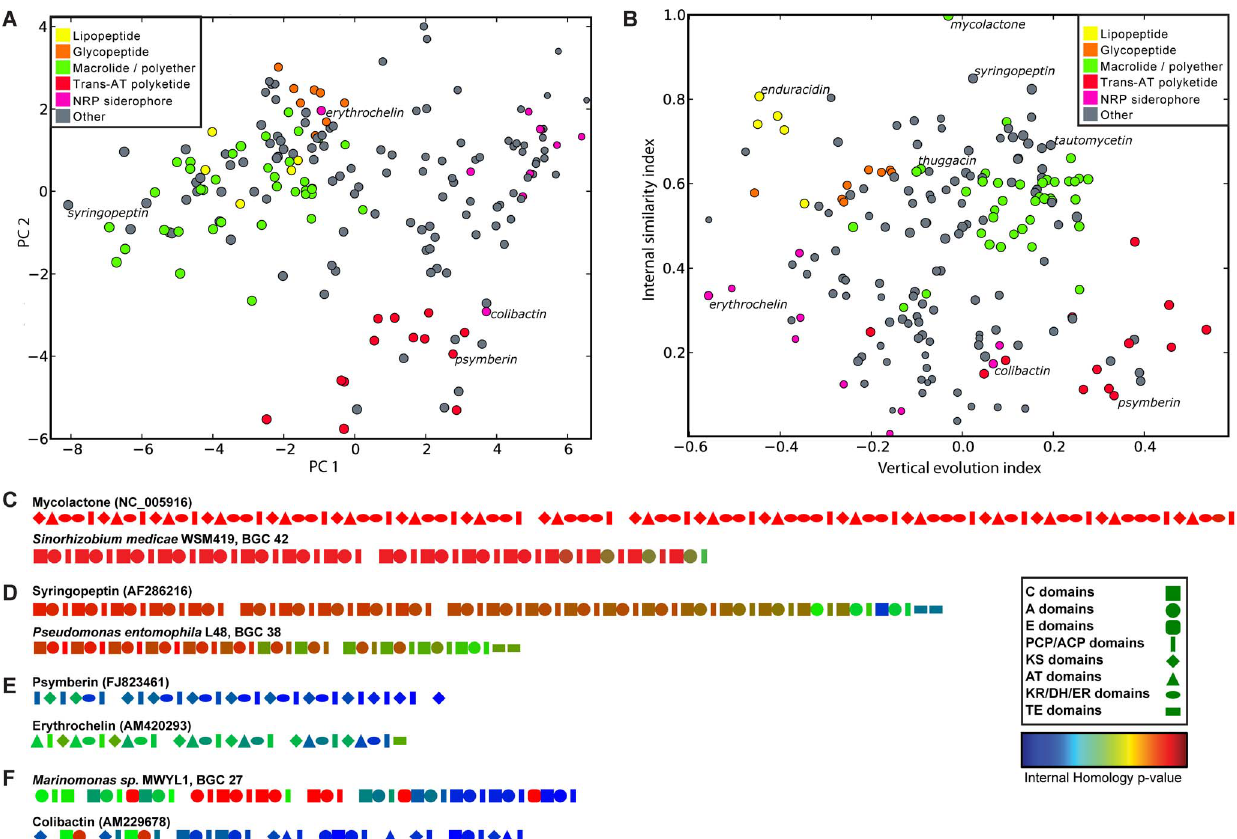
Figure 5. Diverse and distinct modes of evolution for PKS and NRPS BGCs. a , Scatter plot showing the first two principal components resulting from a PCA analysis of different evolutionary characteristics of BGCs encoding different classes of NRPs and PKs. The first two principal components describe 63% of the variance. BGCs encoding members of the same family (e.g., lipopeptides, glycopeptides or macrolides) tend to cluster together, suggesting that their family members evolve in similar ways, while different families cluster apart from each other, suggesting distinct modes of evolution. Colors indicate distinct classes of BGCs. b , Scatter plot showing two features of BGCs – internal similarity index and vertical evolution index – that, of the 25 measured features, underlie most of the variation. The internal similarity index indicates how similar domains in a BGC are to other domains within the same BGC. The vertical evolution index indicates how closely related a BGC is to the BGCs harboring the closest relatives of its constituent domains (see Methods for more details). Colors indicate distinct classes of BGCs, as in panel a . c–f , Domain architecture plots of PKSs and NRPSs show distinct modes of evolution: c , Internal duplication with concerted evolution; d , N-terminal additions by module duplication and recombination; e , domain swapping with other BGCs; and f , mixed evolution. Geometric shapes indicate domain types (see legend); domain colors indicate the internal homology p-value of each domain to its closest relative within the same gene cluster, within the total distribution of all similarities between domains of the same type in the entire data set: hence, domains colored red are most similar, while domains colored blue are most dissimilar.